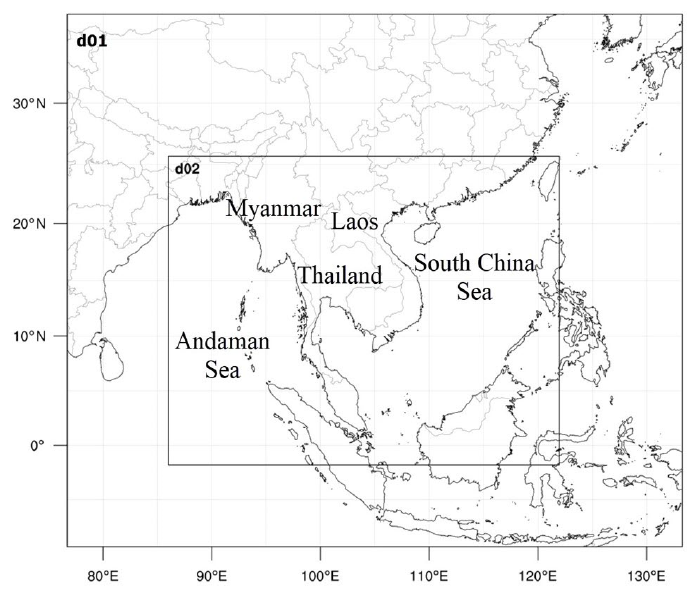
Figure 2. Model domains used for the 3DVAR assimilation method in this study.